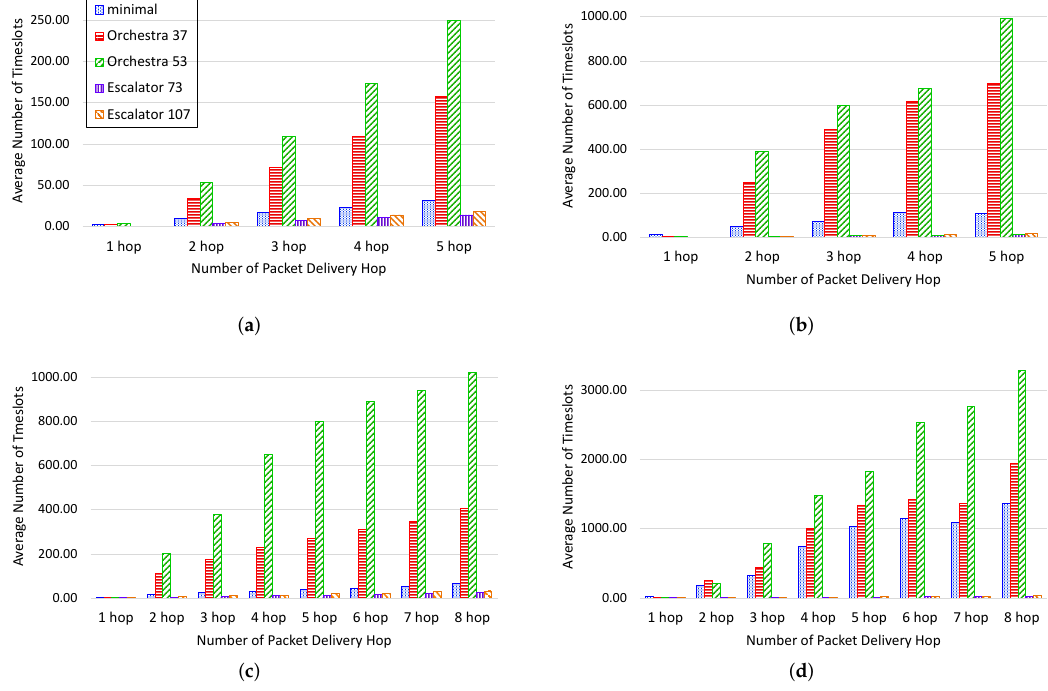
Figure 11. End-to-end delay per packet delivery hops in the simulation: ( a ) a packet transmission interval of 20 s on the 4 × 4 grid; ( b ) a packet transmission interval of 5 s on the 4 × 4 grid; ( c ) a packet transmission interval of 20 s on the 6 × 6 grid; ( d ) a packet transmission interval of 5 s on the 6 × 6